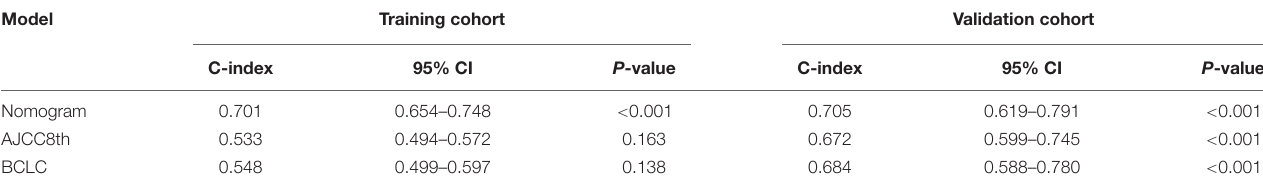
TABLE 3 | Comparison of the predictive ability of models.